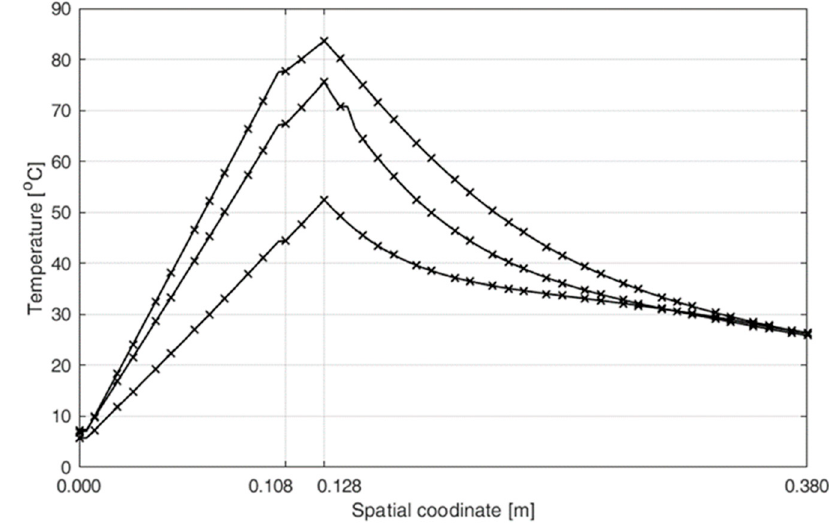
Figure 5. Temperature distribution in the envelope at 10:00 a.m., 12:00 noon, and 2:00 p.m. (from below) calculated at ∆ x = 4 mm (solid line) and at ∆ x = 2 mm (crosses).